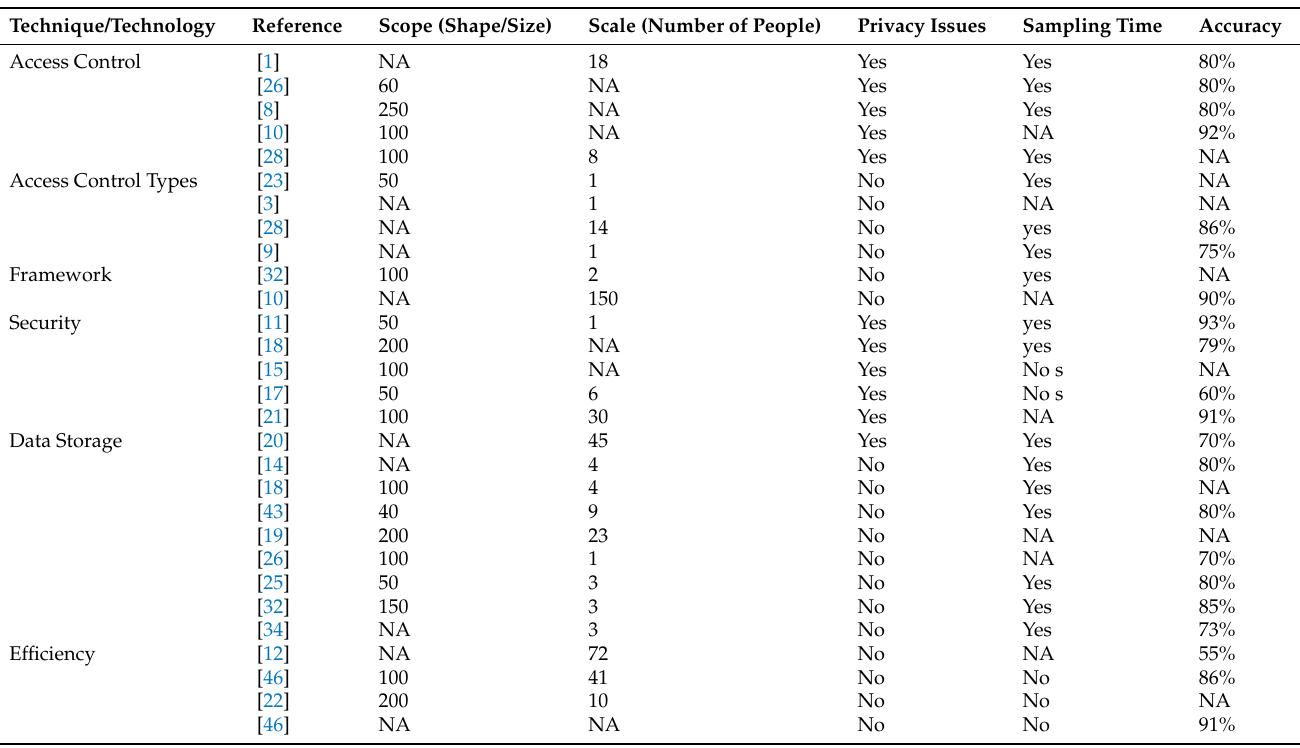
Table 2. Access control type, scope, scale, privacy issues, real time data set used, and accuracies of various occupancy